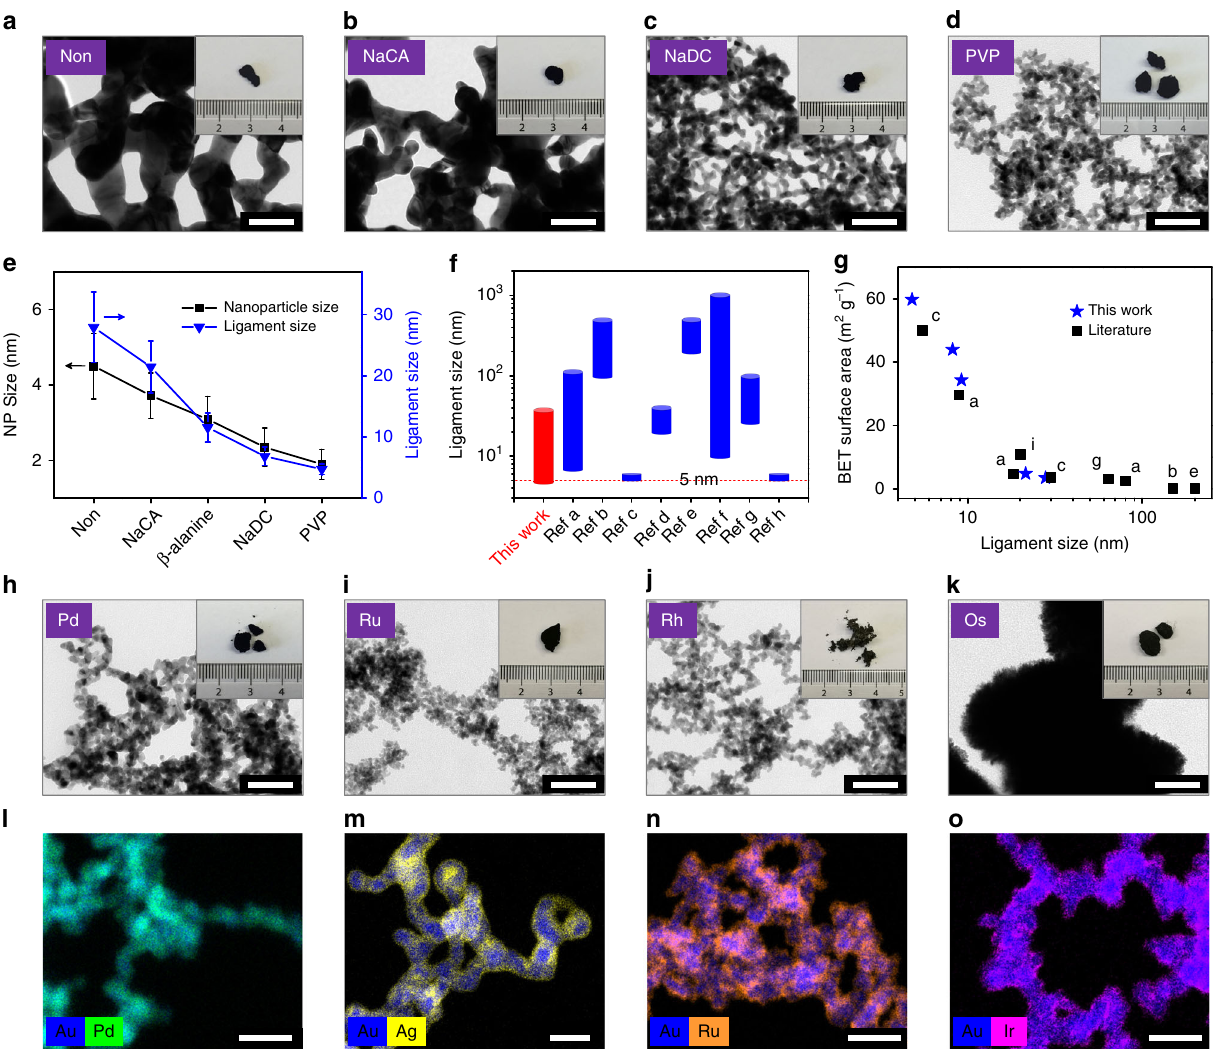
Fig. 3 Versatile manipulation of NMAs. a – d Gold gels fabricated by destabilizing different-ligands-stabilized gold NPs with NaBH 4 , TEM images and photographs (insets). e The size of different-ligands-stabilized gold NPs and the ligament size of the corresponding gold aerogels (as derived from TEM analysis, error bars depict the standard deviation). A comparison of f the ligament size and g the ligament size vs. BET surface area of gold aerogels reported in literature, where panels a – i correspond to the references 5,16,21,24,39 – 43 , respectively. TEM images and photographs (insets) of h Pd, i Ru, j Rh, and k Os aerogels. STEM-EDX maps of l Au-Pd, m Au-Ag, n Au-Ru, and o Au-Ir aerogels. The scale bars are 50 nm in a – d , h – k , and are 20 nm in l – o